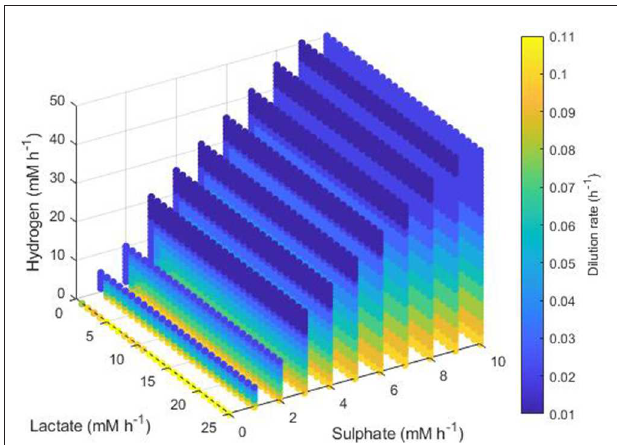
FIGURE 10 | Maximum dilution rates under which the outcome of the model was survival of the SRB only. The axes indicate the inflow rate of each of the three substrates, and the colored points represent combinations of these inflows that resulted in survival of the SRB only at the dilution rate shown on the color bar. Note the inverted lactate axis.